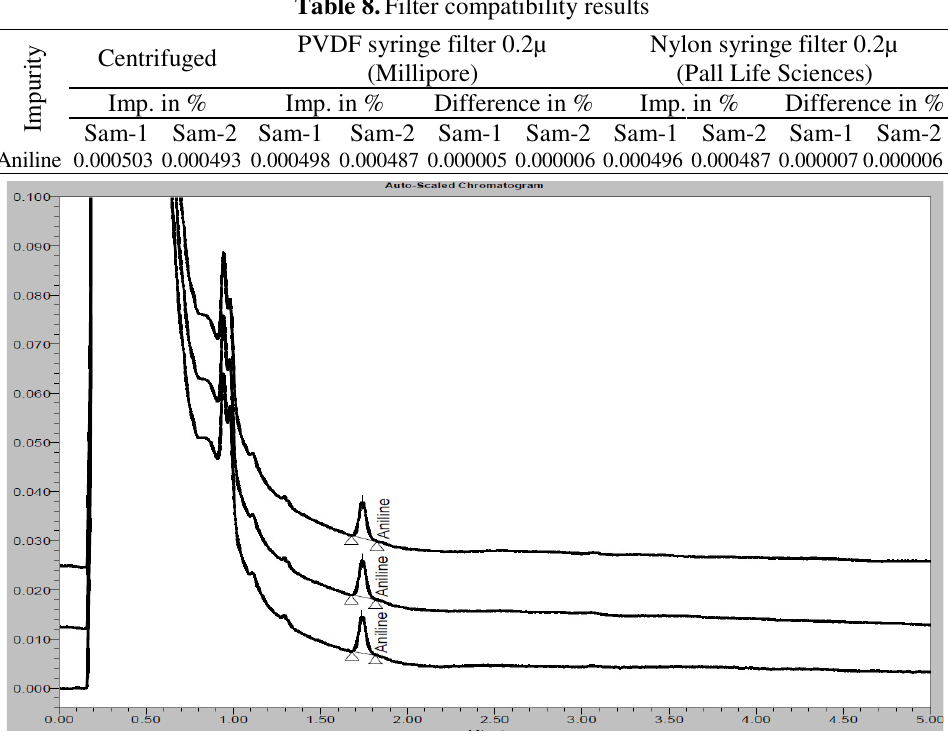
Figure 10. Overlay chromatograms of centrifuge, nylon and PVDF filtered sample